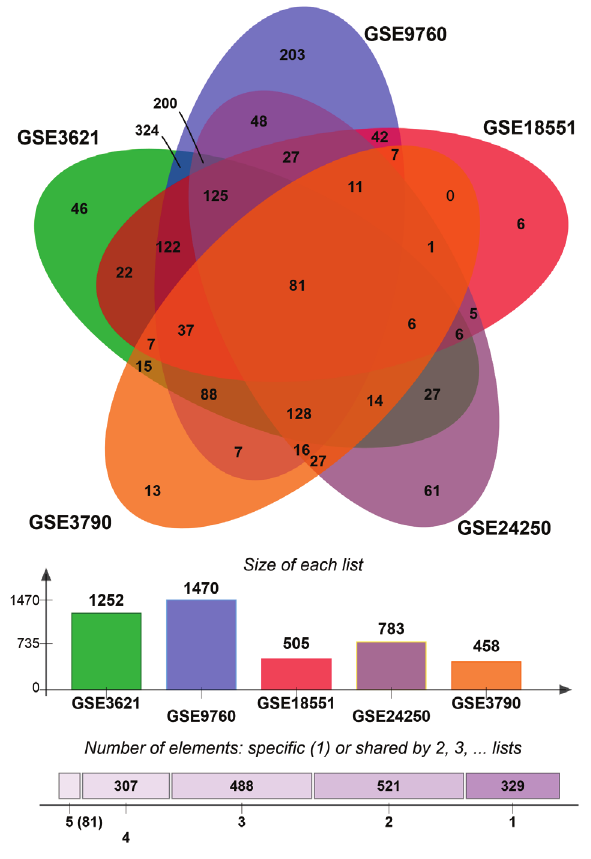
Supplementary Figure 2. Common downregulated UPR genes. Comparison of several HD expression data sets to identify UPR genes that are downregulated in different HD